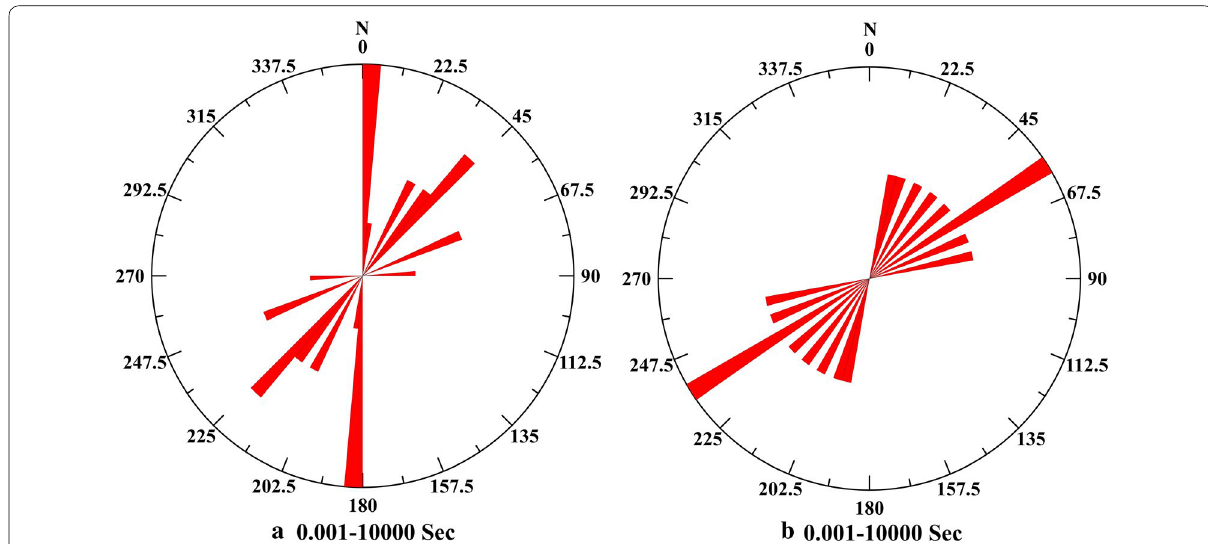
Fig. 2 Rose diagrams showing regional geoelectric strike directions computed from McNeice and Jones (2001) for periods between 0.001 and 10,000 s. a For stations 301–315 and b for stations